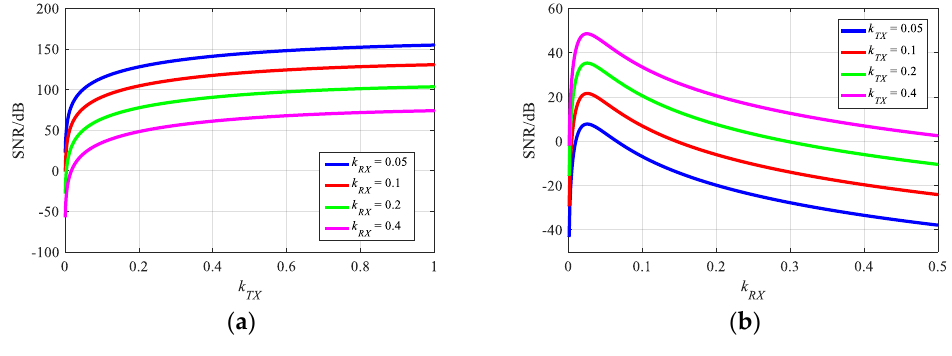
Figure 9. SNR versus ( a ) k TX ; ( b ) k RX .